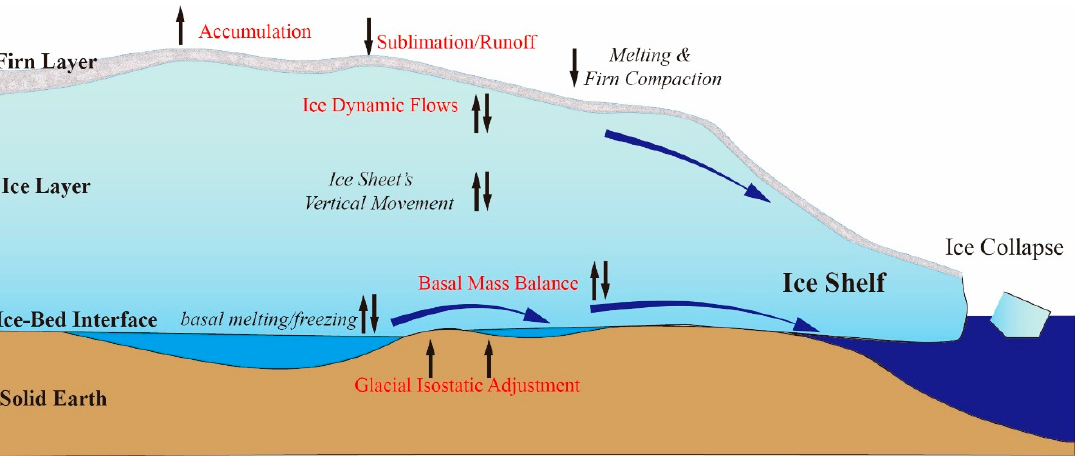
Figure 1. Mass redistributions in AIS. Red texts are components that contribute to mass-changing processes, and italic texts are components related to mass-conserving processes. Vertical arrows next to the texts denote the contribution to height variation.